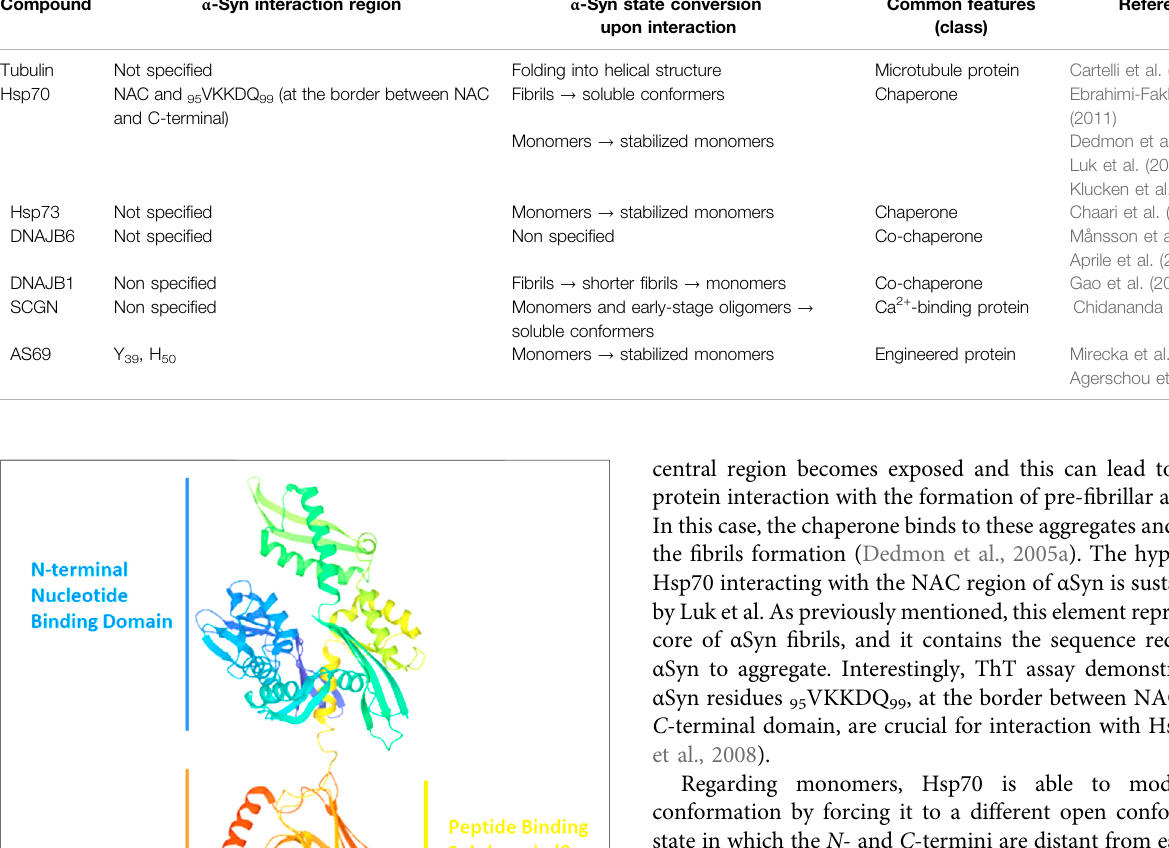
TABLE 2 | Reported proteins interactions with monomeric and aggregated states of α Syn. Compound